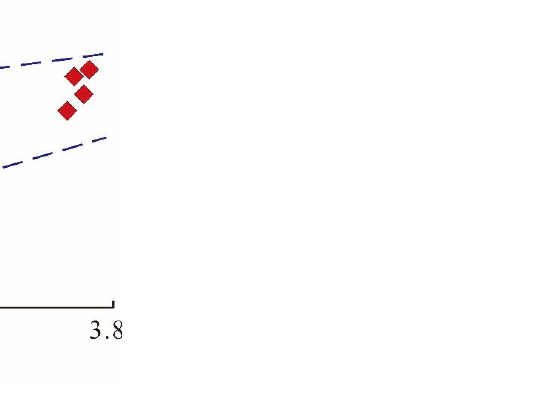
Figure 5. Relationship between comprehensive fractal dimension ( D t ) and vitrinite reflectance (R o ).